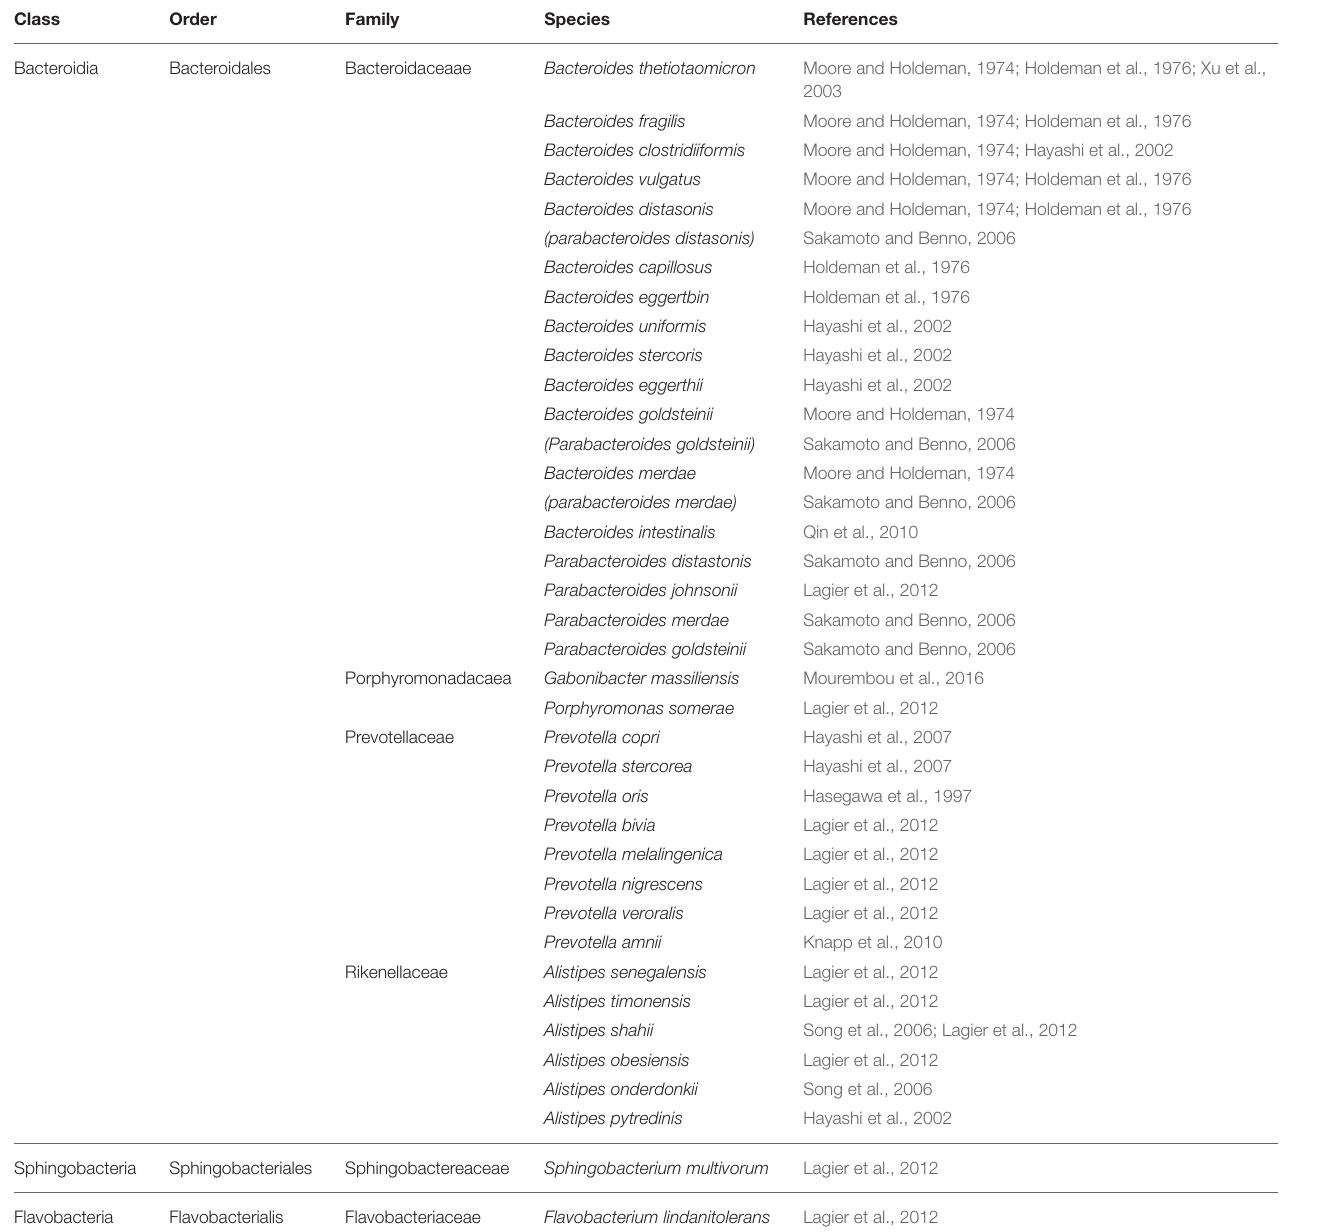
TABLE 4 | Bacteroidetes phylum (class, order, family) and major species constituting the microbiota in healthy human gut.